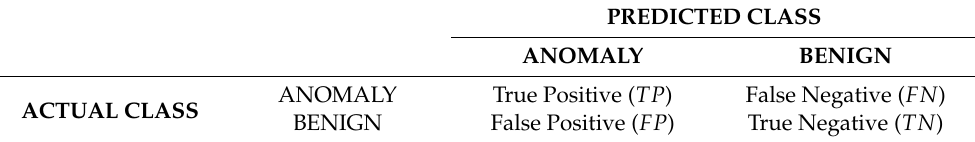
Table 3. A Confusion Matrix.